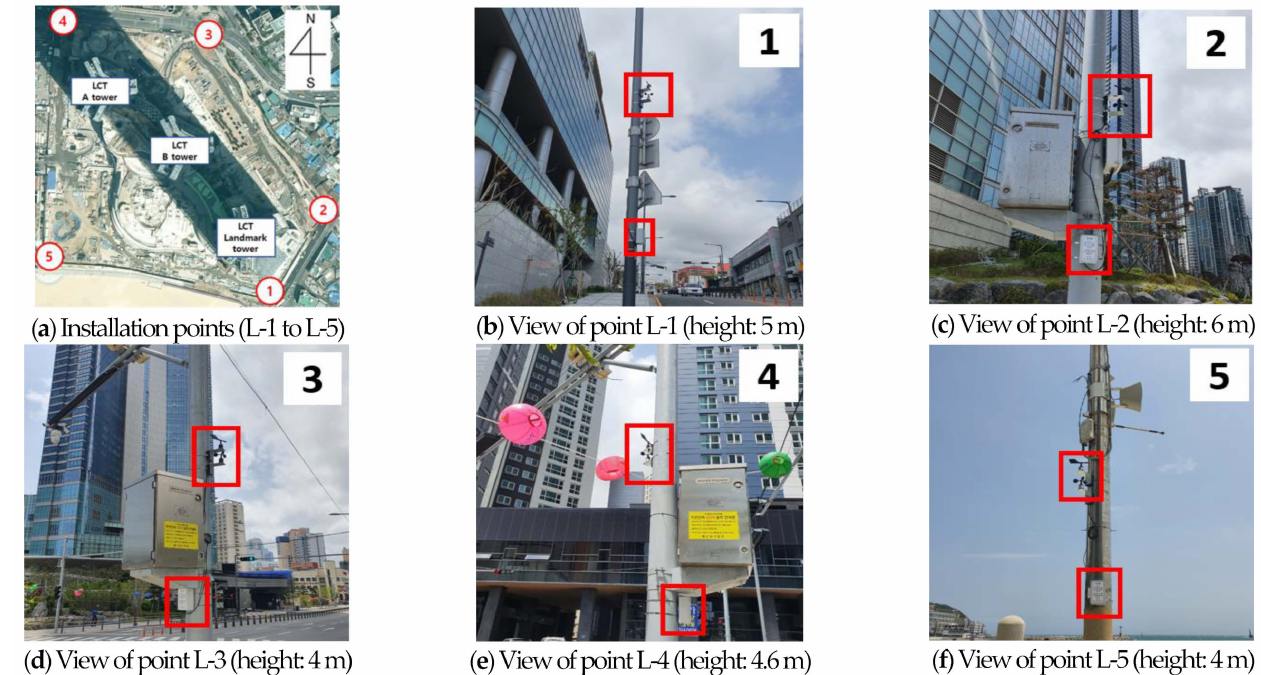
Figure 4. Field measurement points (1~5) around the LCT residential complex. ( a ) Locations of the installation points. ( b – f ) Views of points L-1 to L-5, respectively.